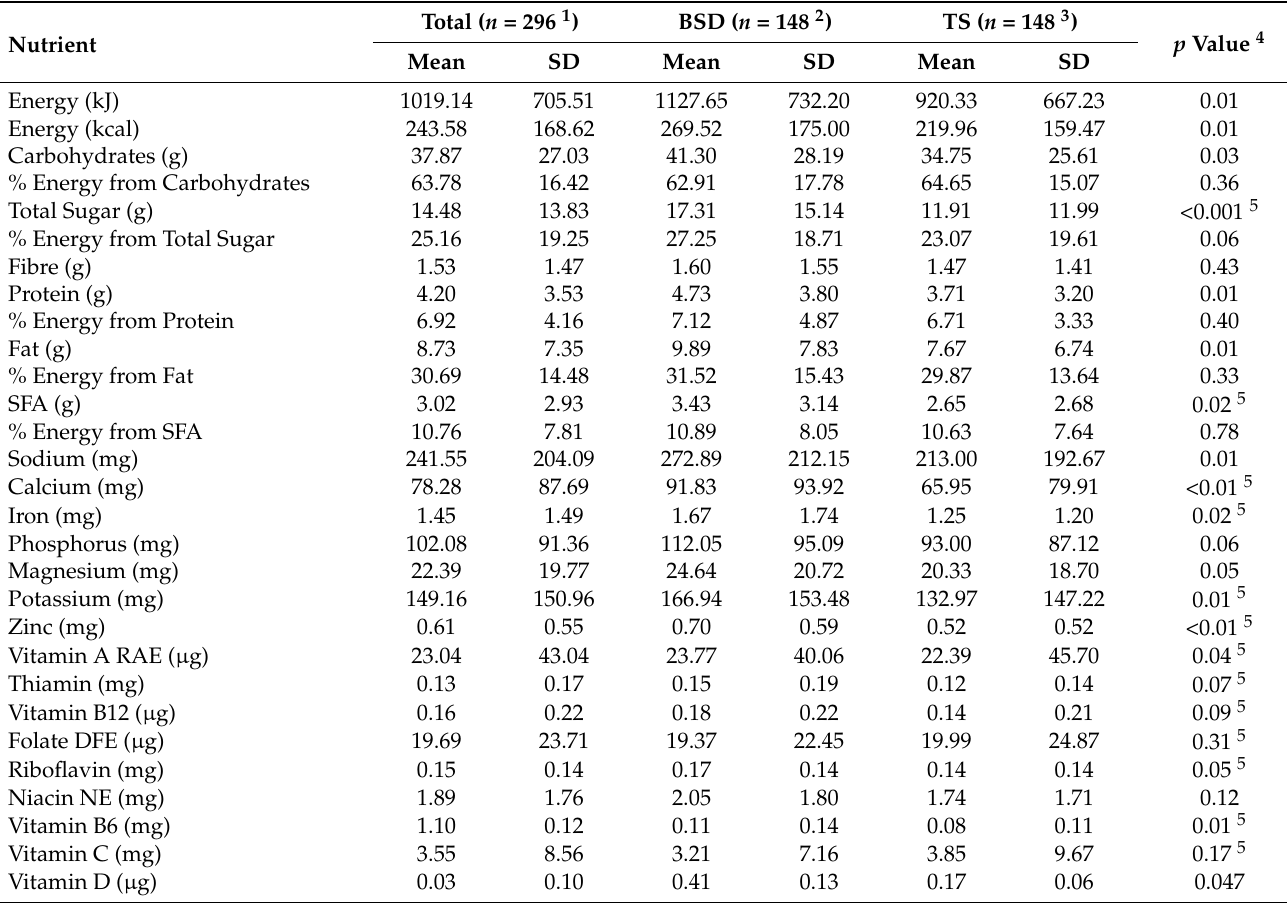
Table 6. Nutrients consumed from snack items by school